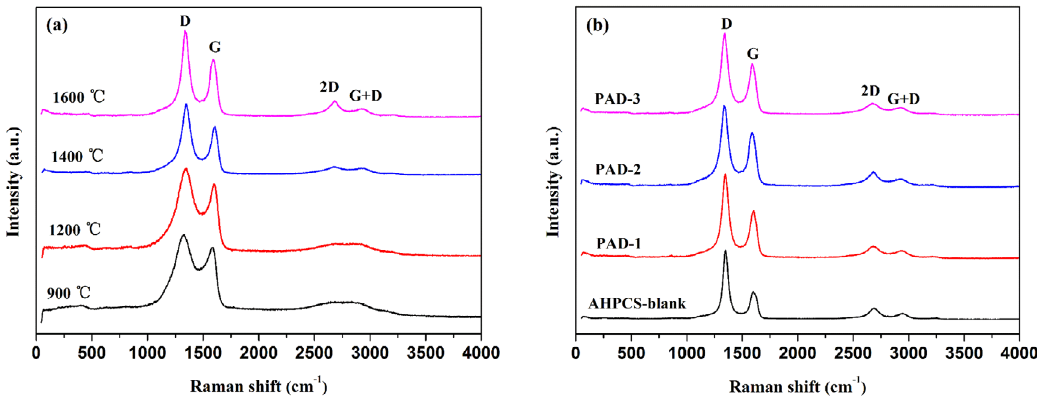
Fig. 4 Raman spectra of (a) PAD-2 derived ceramics annealed at different temperatures and (b) 1600 ℃ ceramics derived from different